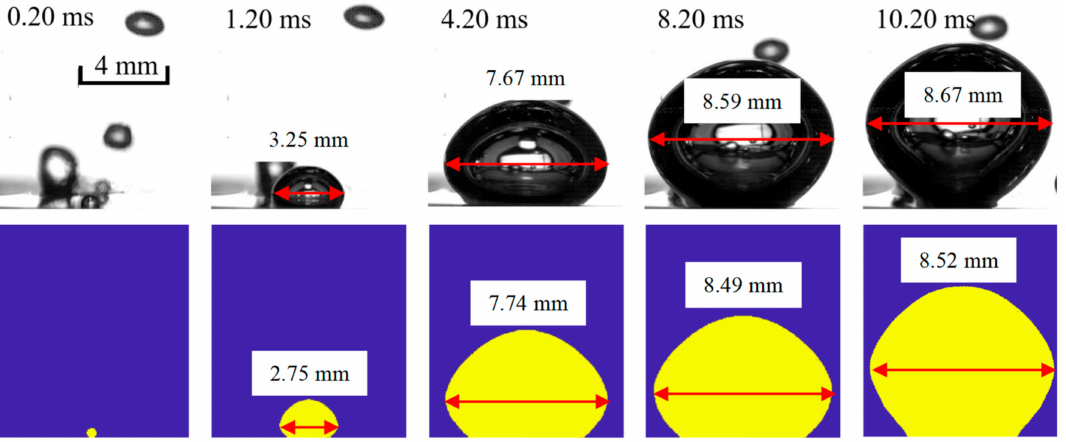
Figure 14. Pool boiling bubble on 100 bilayers LbL ITO heater at ∆ T w = 22.69 ◦ C: HSV snapshots (upper) and present simulation